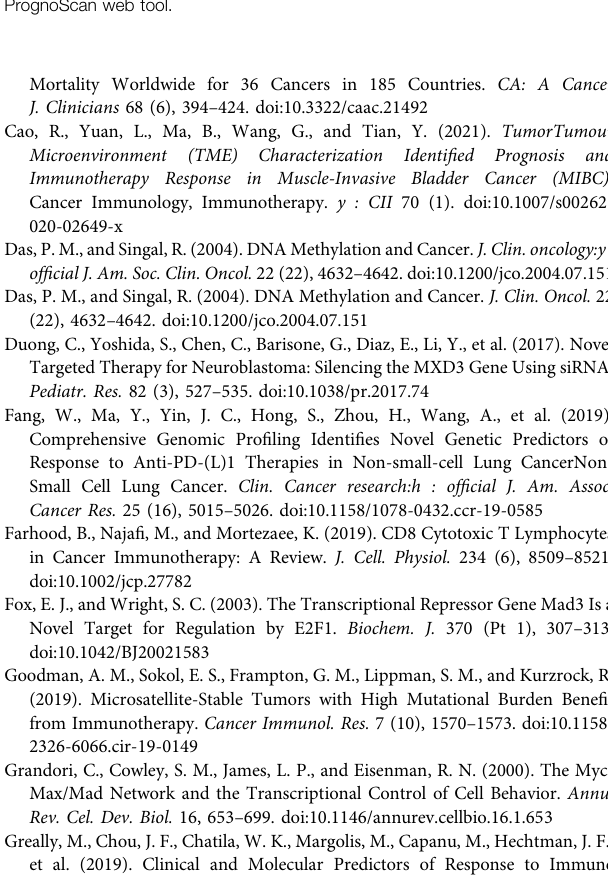
Supplementary Figure S1 | Difference in MXD3 expression in multiple tumors between older ( > (cid:1) 65) and young ( < 65) patients. Supplementary Figure S2 | Differential expression of MXD3 in multiple tumors in different sex groups. Supplementary Figure S3 | Expression of MXD3 in different tumor stages. Supplementary Figure S4 | Stromal score (top) and immune score (bottom) in multiple cancer types. Supplementary Figure S5 | GO analysis of the remaining 25 types of cancer by GSEA. Supplementary Figure S6 | Survival curve of the bladder cancer (a, b) and melanoma (c, d) in the ICI cohort. Supplementary Table S1 | Log2 (fold change) of MXD3 between the drug response group and the non-response group across multiple drugs. Supplementary Table S2 | Tumor MXD3 prognosis data obtained from the PrognoScan web